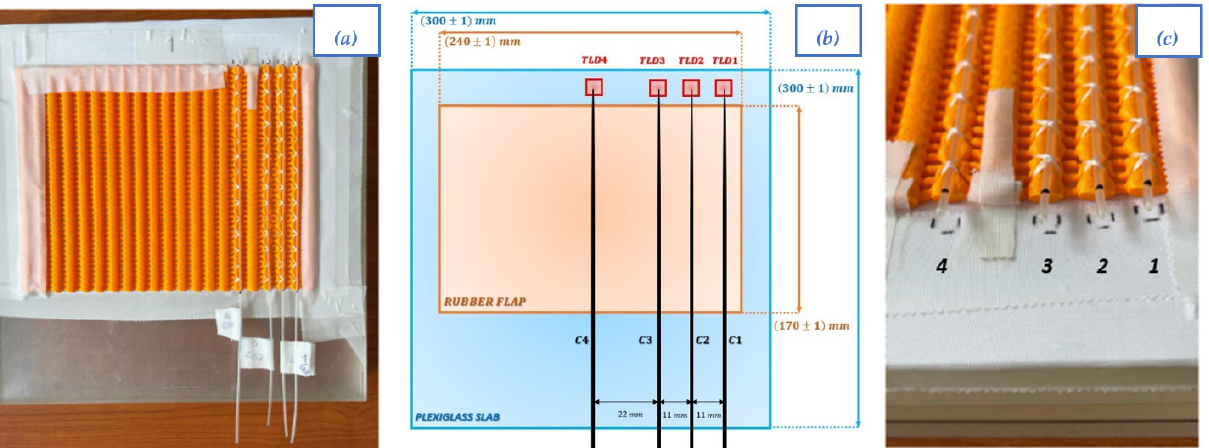
Figure 3. View from above ( a ), schematic representation of the same view with dimensions, where red squares indicate the position of the TDLs, ( b ) and front view ( c ) of the surface applicator and the phantom. Catheters were labelled as C1, C2, C3 and C4 as well as TLDs as shown.